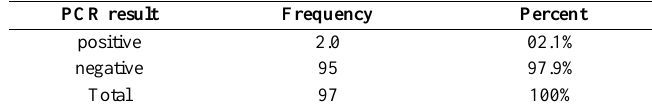
Table 1: Frequency of PCR results